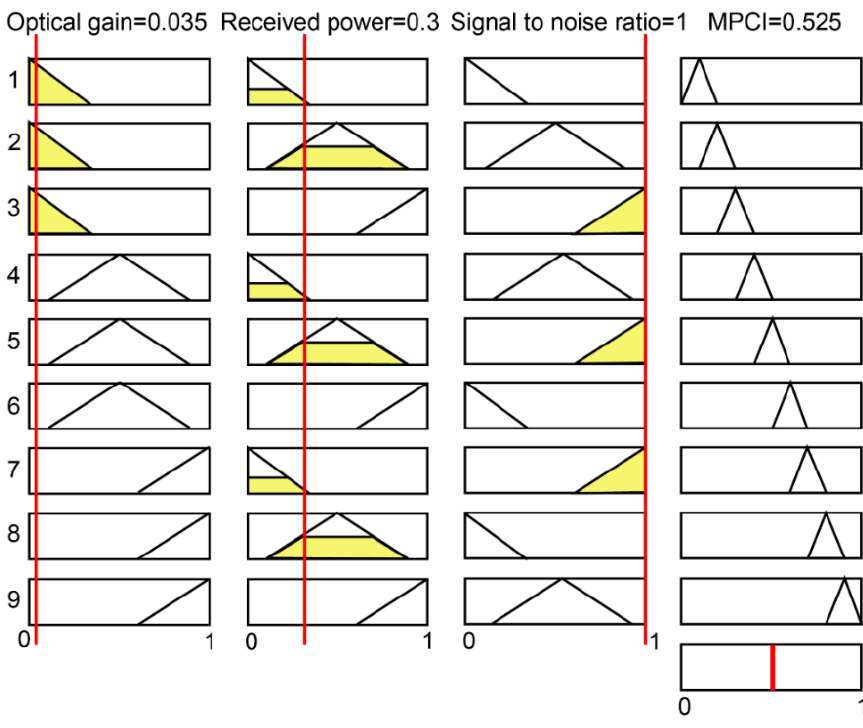
Figure 9. The fuzzy logic reasoning procedures for the optical receiver.